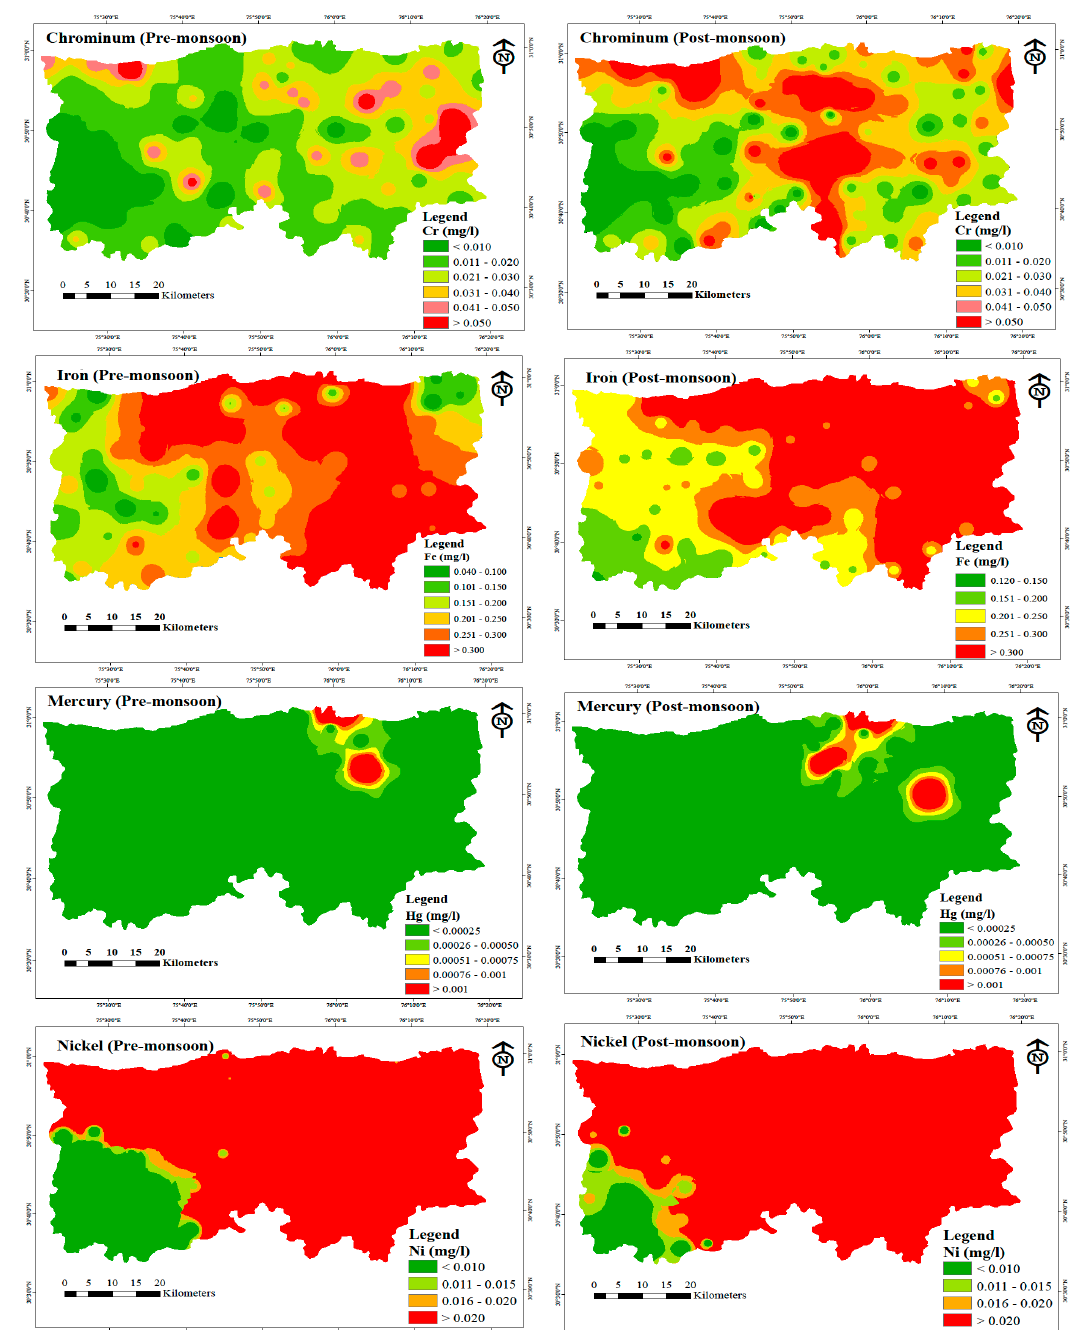
Figure 2. Geospatial variation of ESEs during pre- and postmonsoon periods.